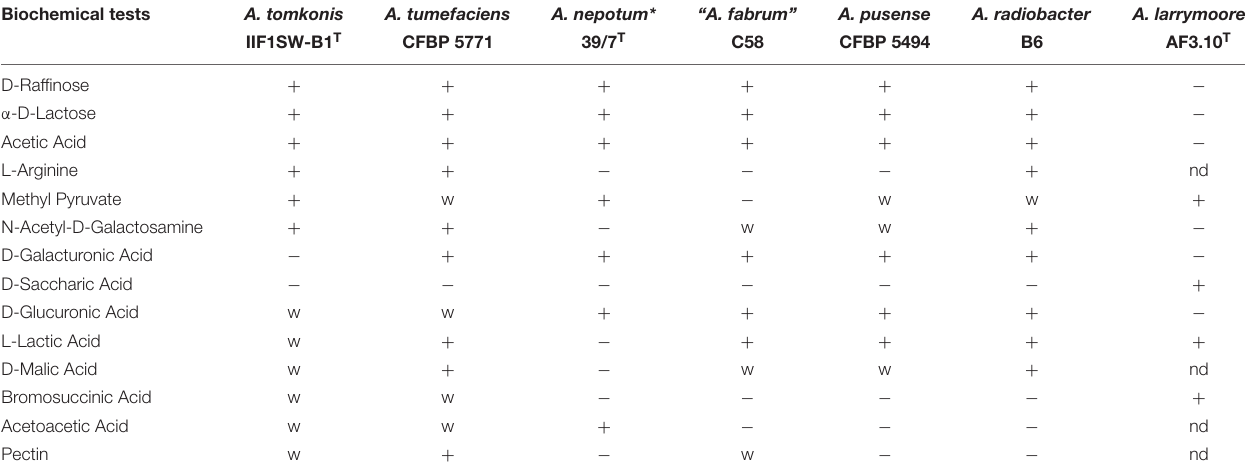
TABLE 3 | Differential biochemical characteristics between A. tomkonis and closely related species. Biochemical